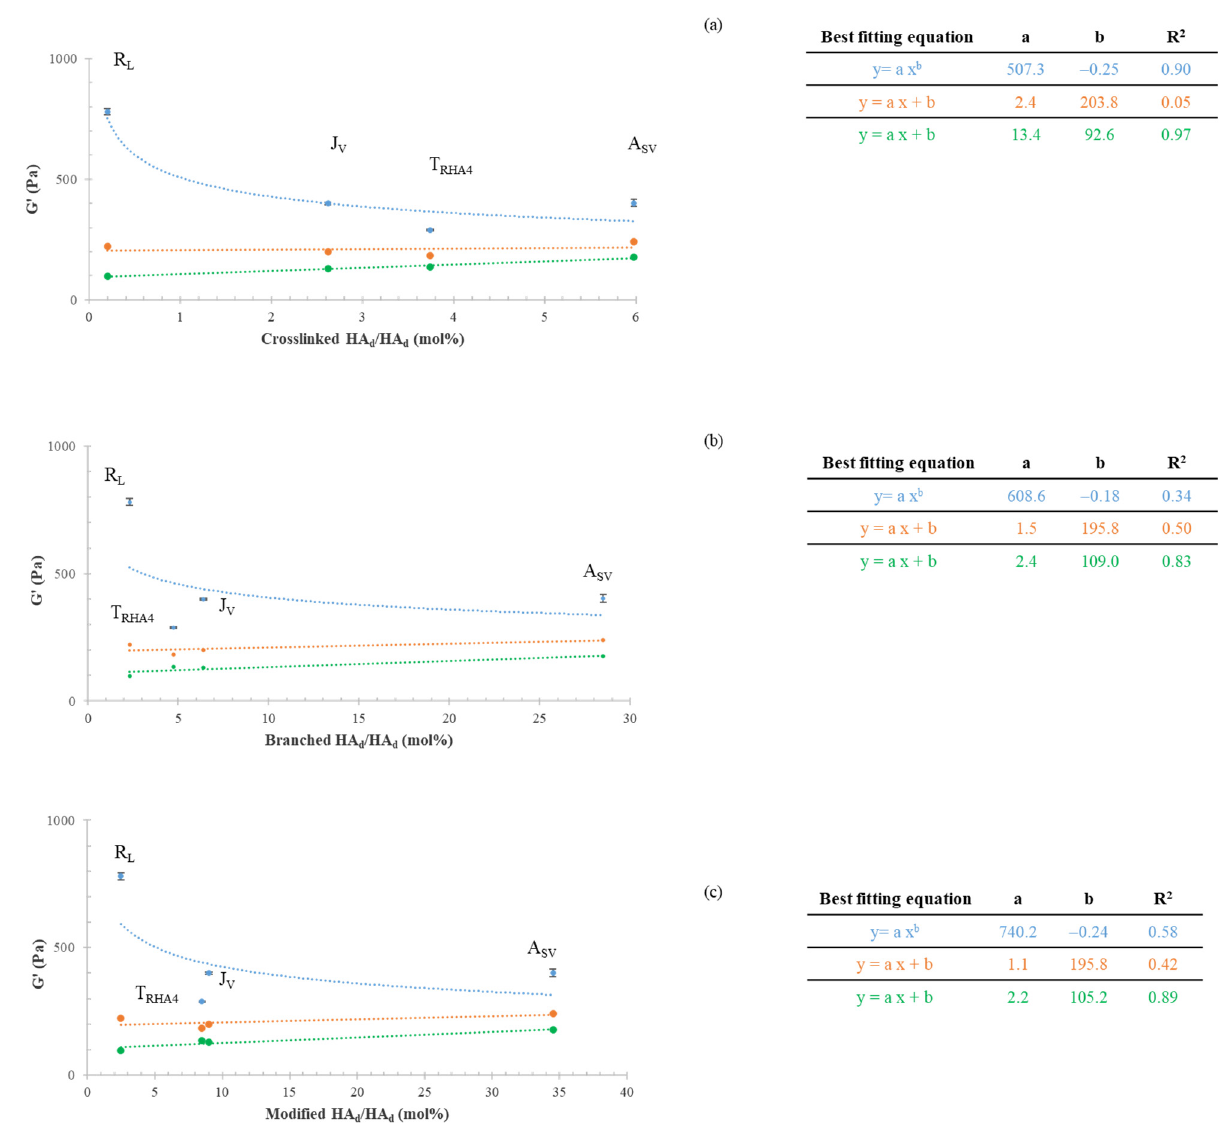
Figure 5. Correlation of G (cid:48) with the HA chemical modification parameters of the gels while hydrating. G (cid:48) as a function of crosslinked HA d (%) ( a ), branched HA d (%) ( b ), and modified HA d (mol%) ( c ) with increasing hydration in a physiological medium. Specifically, the curves for the G (cid:48) values measured for the gels in the syringe (blue) and after twofold (orange) and threefold (green) hydration in the physiological medium are shown. The equation for the best-fitting curve and the related parameters are also shown for each set of experimental